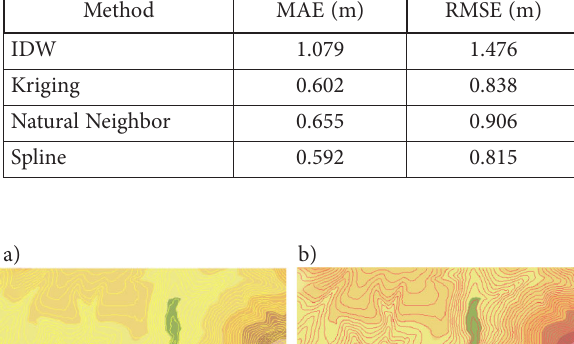
Table 1. Results on MAE and RMSE analysis